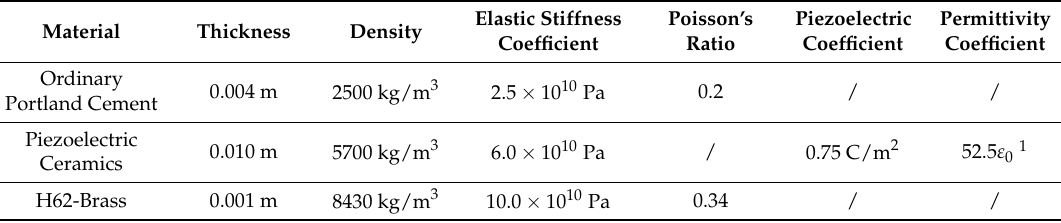
Table 1. Properties of piezoelectric ceramics, elastic electrode and